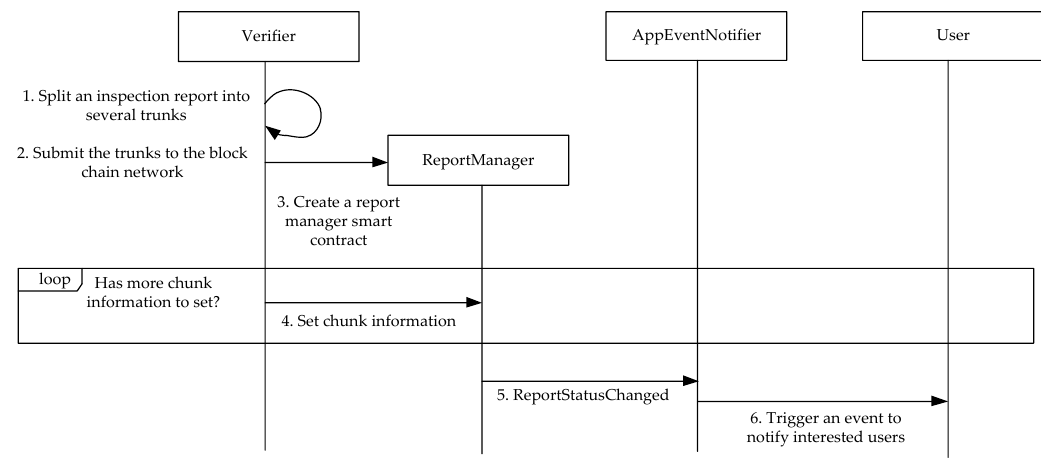
Figure 8. The report creation process.